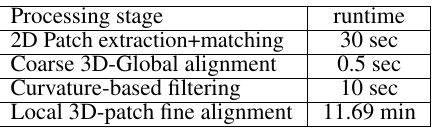
Table 2. Computation time obtained for the dataset Fabas, with N = 4 homologous